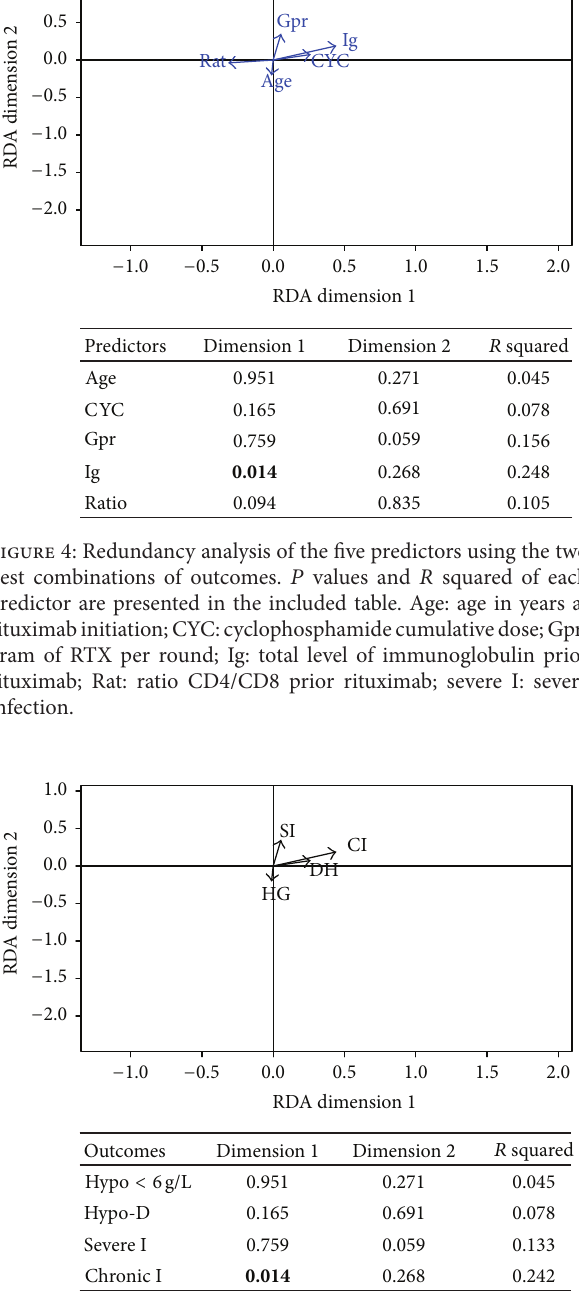
Figure 5: Redundancy analysis of the outcomes using the two best combinations of outcomes. 𝑃 values and 𝑅 squared of each outcome are presented in the included table. CI: chronic infection; DH: discontinuation due to hypogammaglobulinemia; HG: hypogam- maglobulinemia defined as total Ig < 6g/L; SI: severe infection.